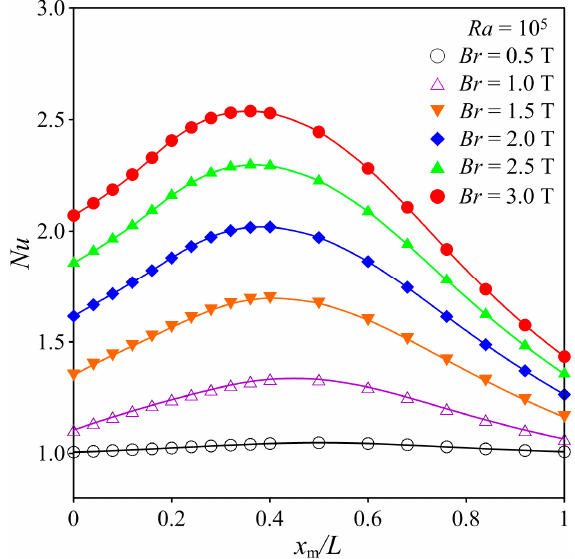
Figure 12. Effect of location of magnet on Nu for different values of Br .